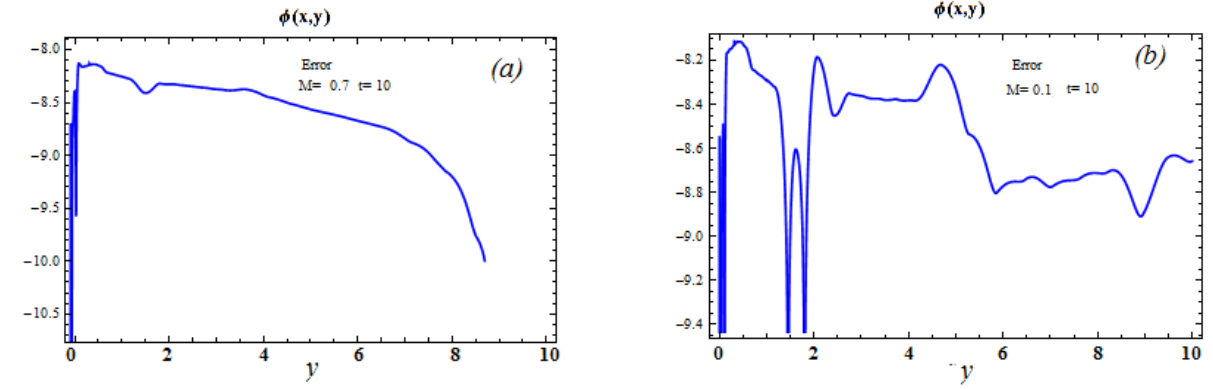
Figure 5. Concentration error analysis for physical parameters ( a ) M = 0.7 and ( b ) M = 0.1.